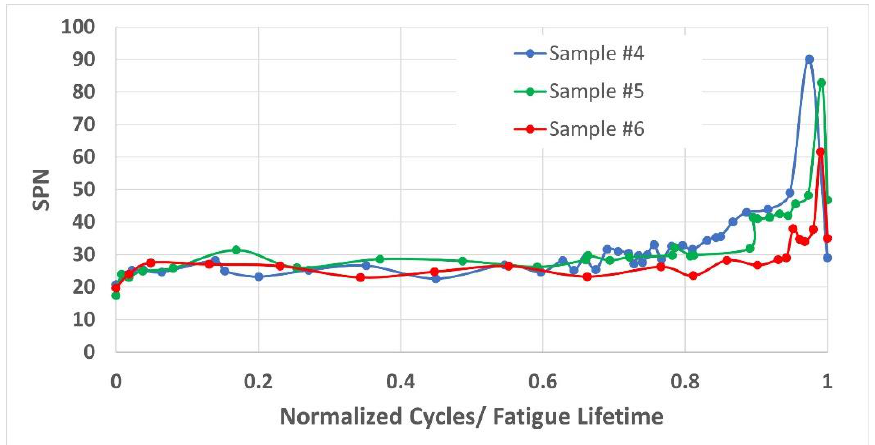
Figure 9. Three specimens were successfully examined by the SPN versus the number of cycles ratio for average frequencies.